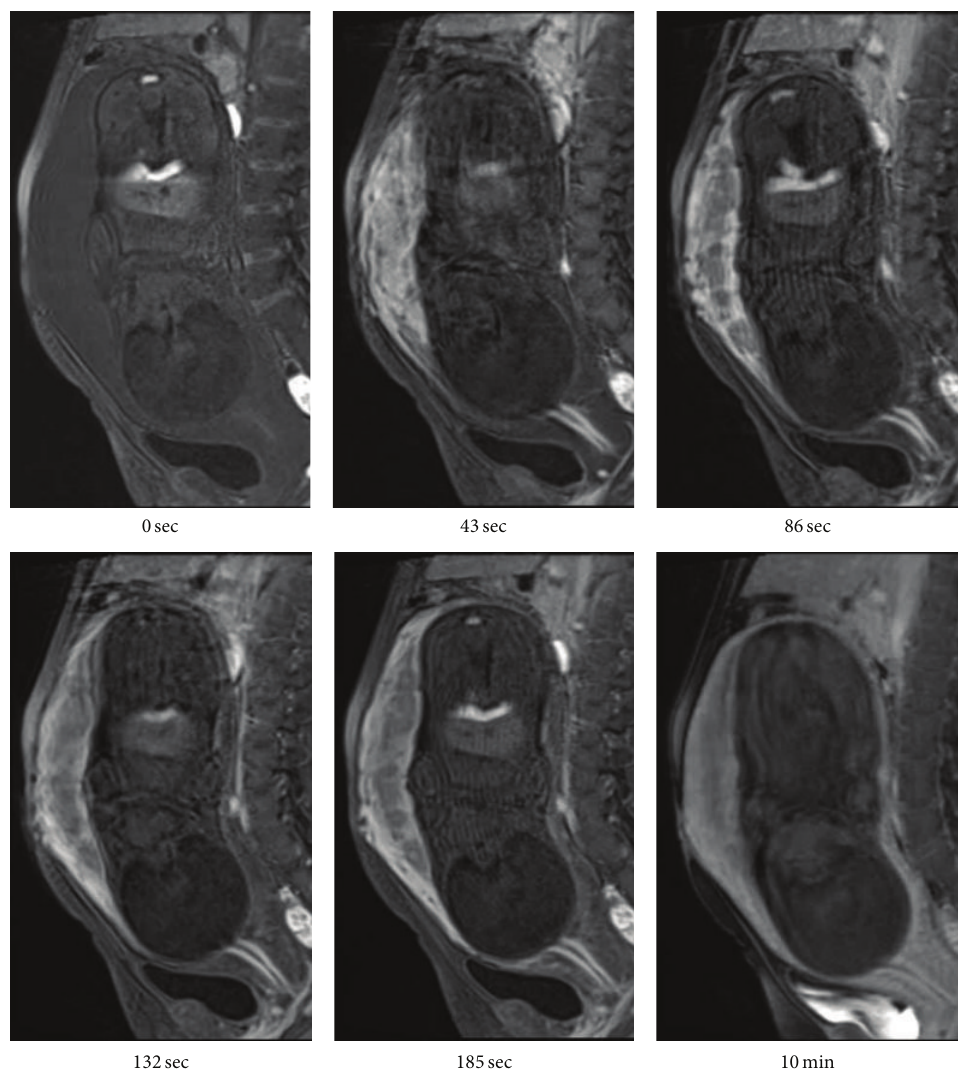
Figure 4: Dynamic contrast-enhanced-MRI using gadolinium at 37 weeks of gestation revealed that the myometrial lesion was enhanced slowly and showed homogeneous enhancement even on a 10min delayed image, whereas the placenta demonstrated marked arterial enhancement and subsequent rapid washout.